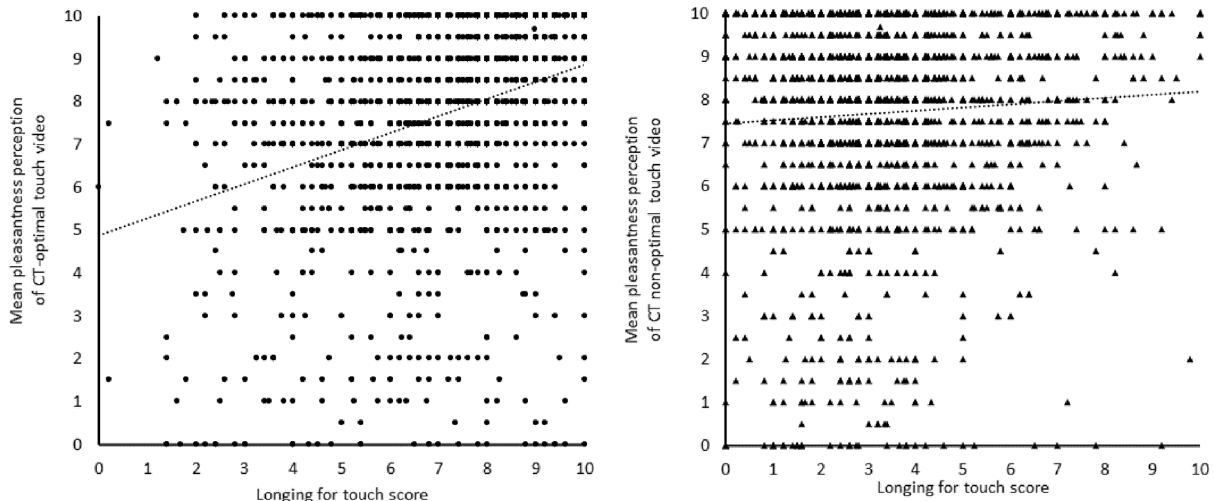
Figure 1. The relation between longing for touch and pleasantness perception of CT-optimal and CT non- optimal videos. The left panel depicts the individual data points and relation between longing for touch and pleasantness perception of the CT-optimal video. The right panel depicts the individual data points and relation between longing for touch and pleasantness perception of the CT non-optimal